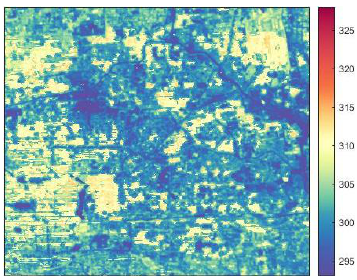
Figure 8. LST Prediction for 09/18/19